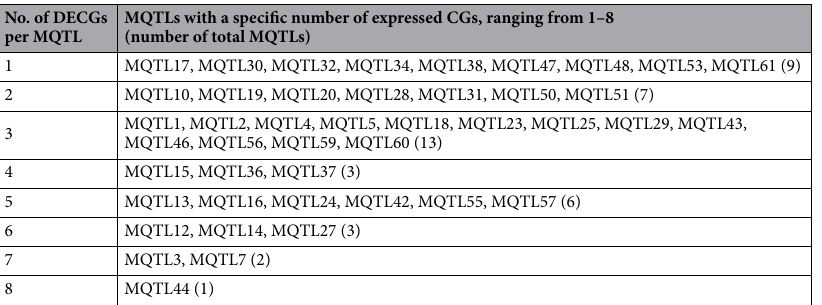
No. of DECGs per